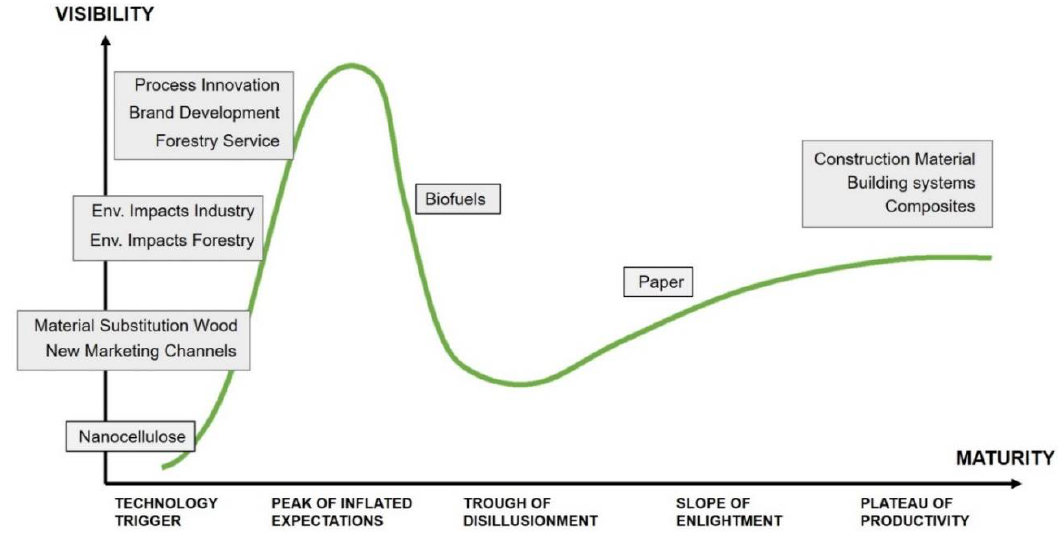
Figure 6. Schematic position of the investigated innovation areas in Gartner’s technology hype cycle.